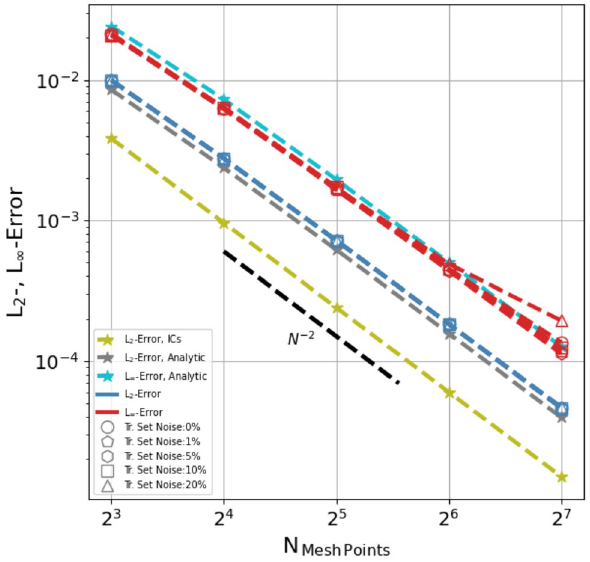
Figure 9. Convergence test: L 2 and L inf error norms for the implementations using an MLP model of the flux gradient (blue and red, respectively) and for the implementation using instead an analytic expression (gray and cyan, respectively, with the cyan curve multiplied by 1.15 to make it visible). The plotted errors are averages over a sample of 30 runs using different, randomly chosen, unperturbed values of the thermodynamic parameters, ( n , T , β ). Models trained with data characterised by different pre-regularization noise are represented by different symbol (see legend), though they are difficult to distinguish as their calculated error data points mostly overlap. The L 2 error norm is also shown for the initial conditions (olive). Expected error drop rate for a second order accurate scheme is indicated by the black dash